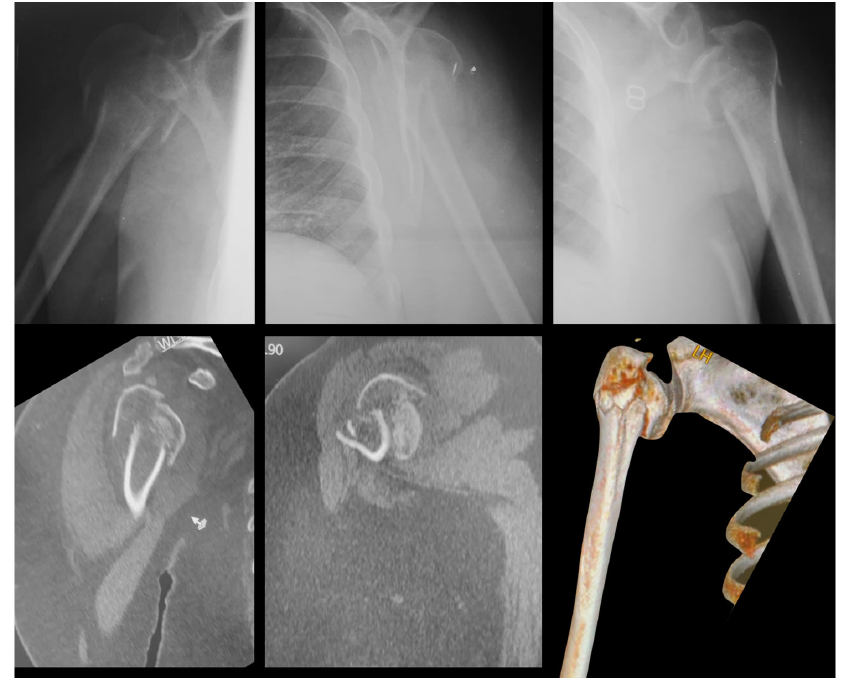
Figure 4. Radiographic and CT images of a 67 ‐ year ‐ old female patient with a right proximal humerus fracture (Case 9). Note that it is possible to observe the split ‐ head fracture of the head (Criterion C) only on CT, especially in 3D reconstruction. The fracture was classified as Neer 4 ‐ parts. The images were sent by email to eight board ‐ certified orthopedic surgeons with more than 10 years of experience in the treatment of proximal humerus fractures (Observers 1–8), in 20 individual folders, along with instructions on how to respond